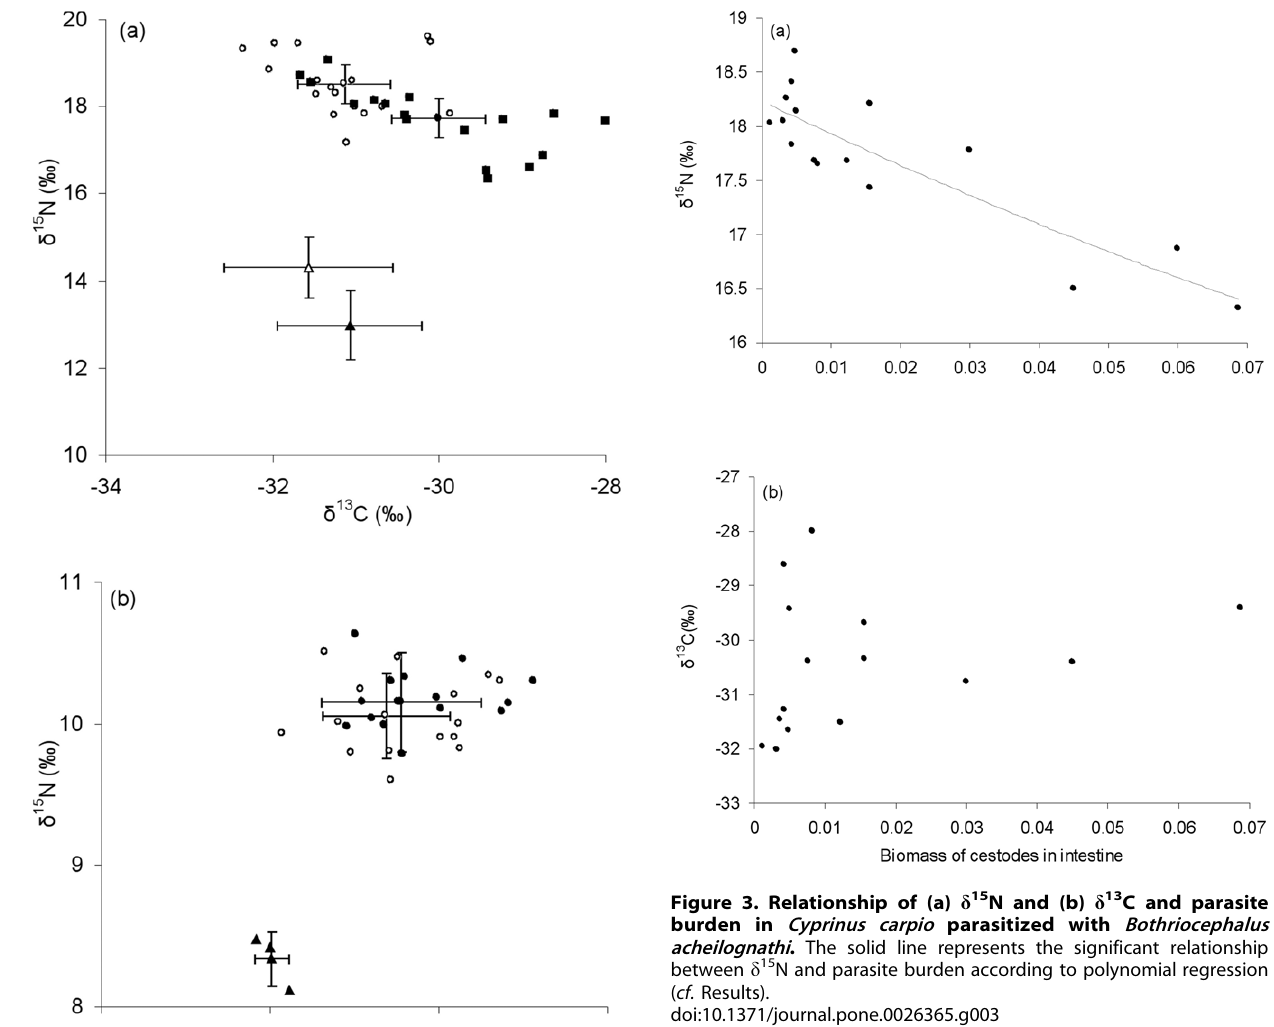
of d 15 N (polynomial regression: R 2 = 0.75; F 2,13 = 19.90, P , 0.01), but this was not apparent for d 13 C (linear regression R 2 = 0.15; F 1,14 = 2.44, P . 0.05) (Figure 3).